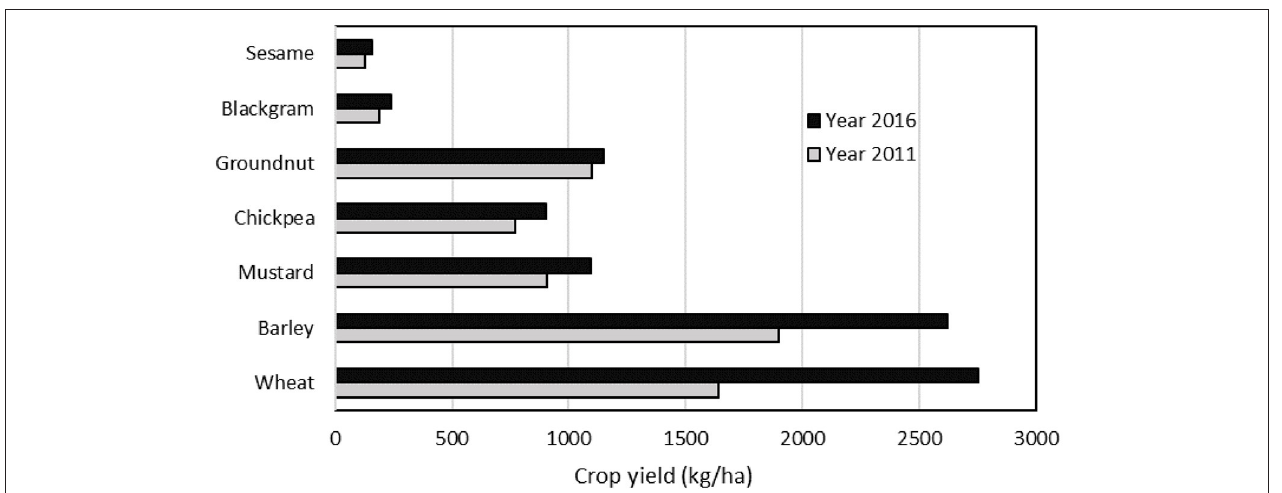
FIGURE 9 | Comparison of crop yield before (2011) and after (2016) project